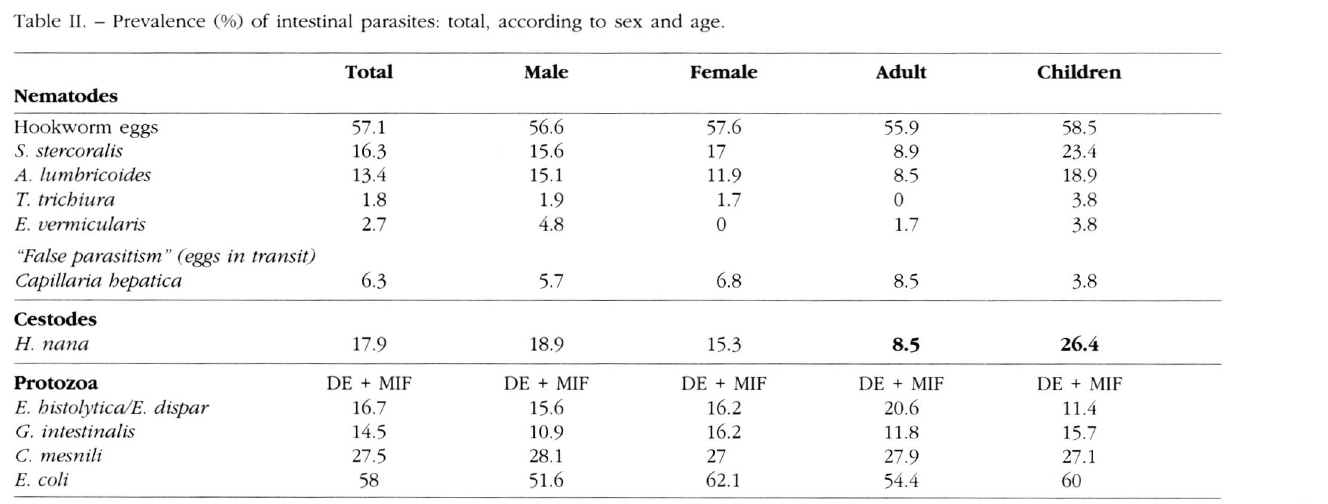
Tabic 11. - Prevalence (%) of intestinal parasites: total, according to sex and age.